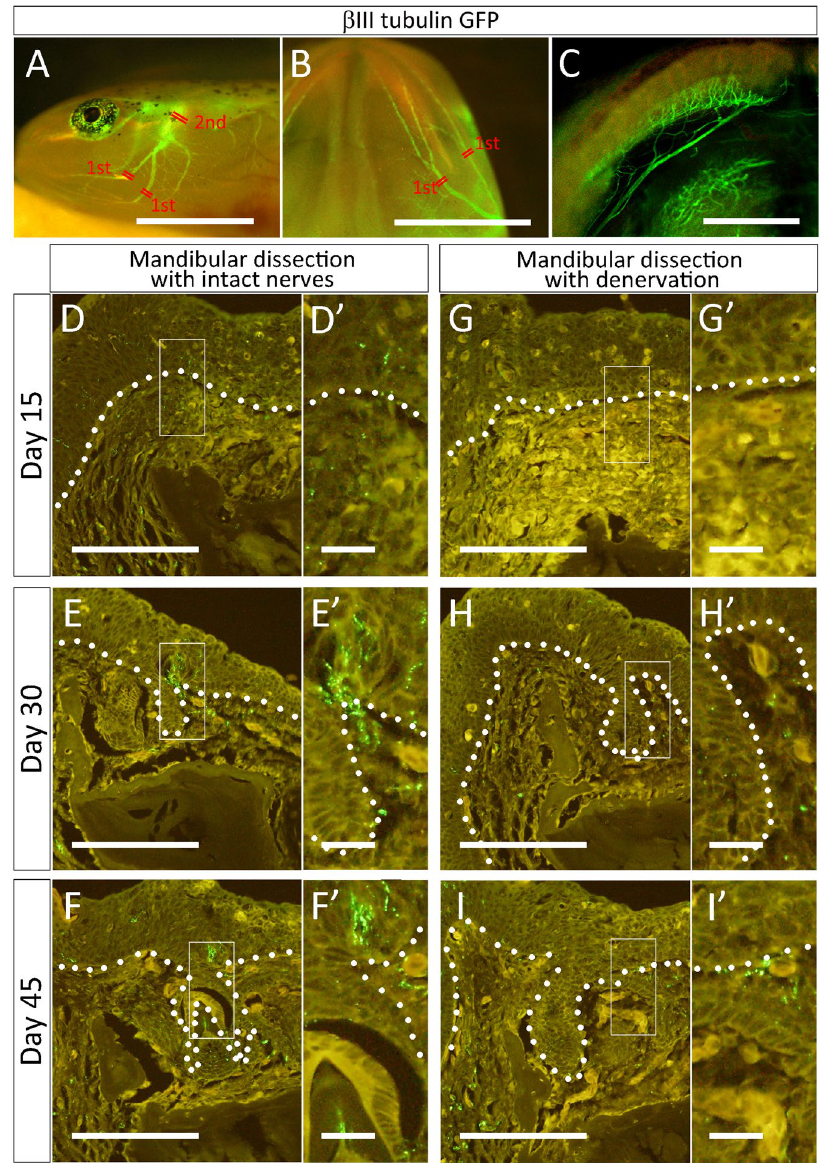
Figure 5. Nerve presence in the axolotl mandible and a regenerating tooth. β III tubulin-GFP transgenic axolotl tissues show the presence of axons. ( A–C ) GFP signals in normal (control) axolotl mandible. ( A ) Lateral view. ( B ) Ventral view. ( C ) Dorsal view of the mandible. Subsequently, the lower jaw was dissected out and pictures were taken from the dorsal side. ( D–F ) Nerve presence in the regenerating tooth. GFP positive nerve fibers were visualized by anti-GFP antibody on the sections. D’–F’ are higher magnification views of the boxed regions in D–F. ( G–I ) Nerve presence in the regenerating tooth in the denervated mandible. G’–I’ are higher magnification views of the boxed regions in G–I. Scale bars in A, B, and C are 5, 5, 1. Scale bars in D–I and D’–I’ are 0.3 and 0.05 mm, respectively. The dotted lines indicate the border of the oral epithelium. Data are representative of 4 independent